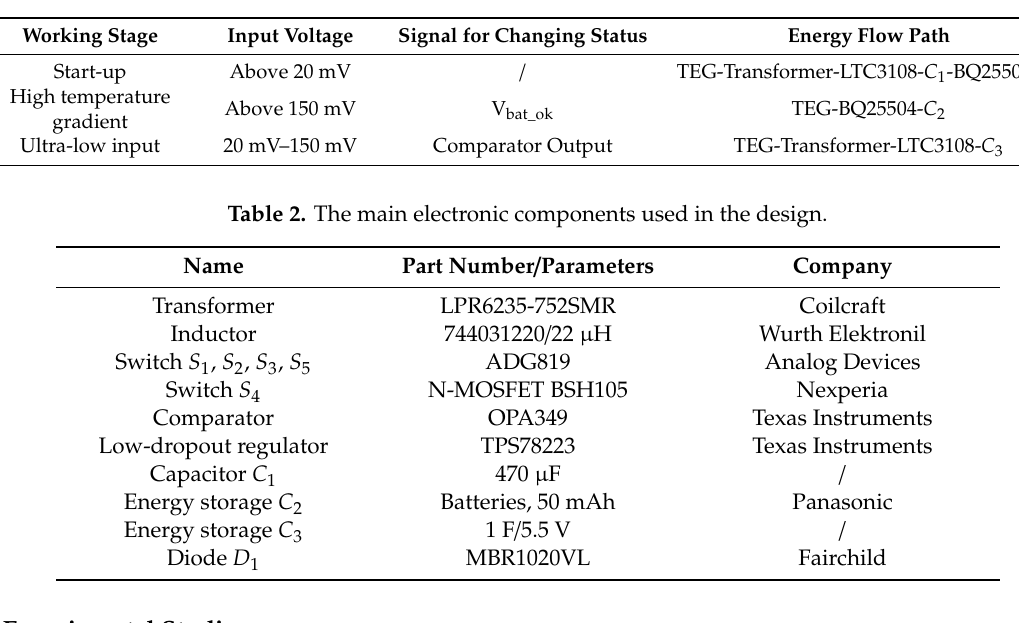
Table 1. Working principle of proposed PMS.